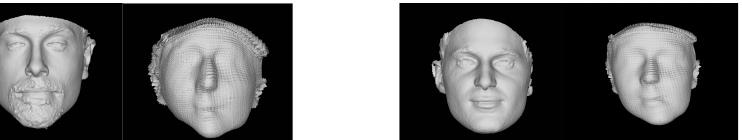
Figure 19. Two 3D facial meshes from the MICC Florence dataset ( left part of each pair) compared to the reconstructed 3D facial meshes made by the synthetically trained 2-input network ( right part of each